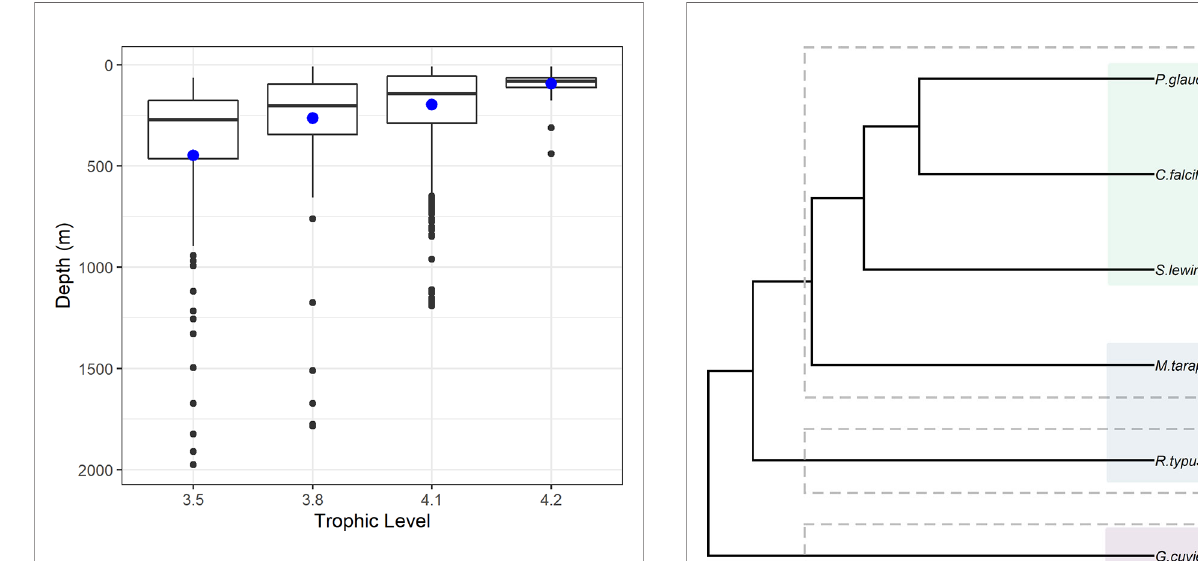
FIGURE 3 | Boxplots of the distribution of maximum diving depths in relation to trophic level in pelagic elasmobranch species. The bold horizontal line depicts the median, the solid horizontal lines in the box depict the interquartile range, the vertical solid lines represent the distribution range, and the solid circles depict potential outliers. The larger, solid, blue circles depict the mean maximum diving depths for each trophic level. Note the decreasing trend in maximum diving depths with increasing trophic levels.